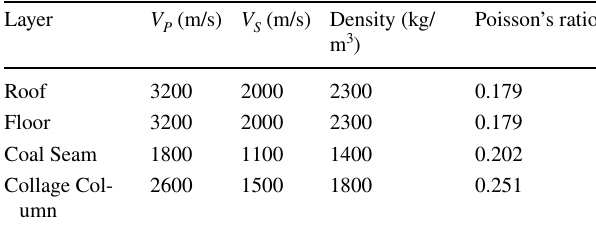
Table 1 Petrophysical parameters of the working face